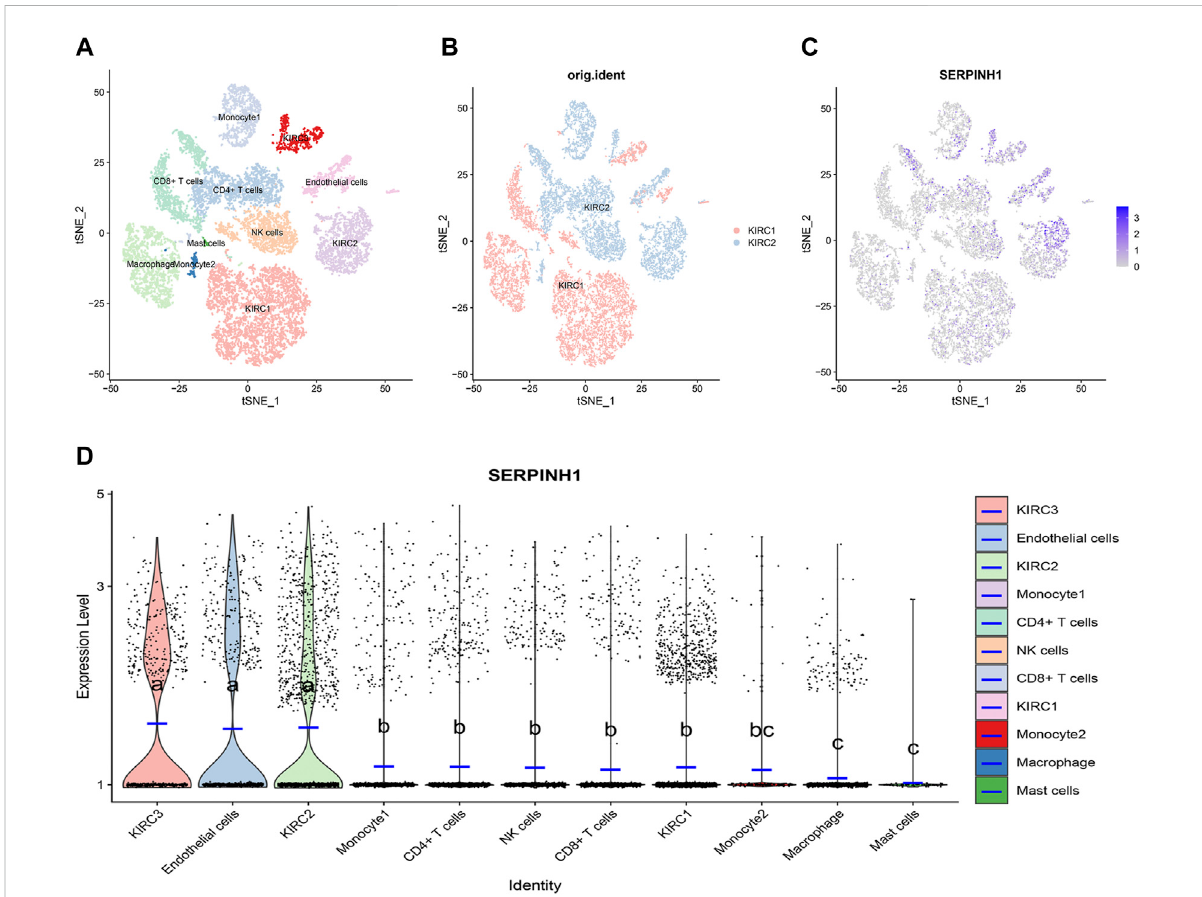
FIGURE 13 Single-cell transcriptomic Atlas of KIRC. (A) tSEN plot representation of KIRC samples with 11 distinct cell types. (B) tSEN plot representation of KIRC from two different samples. (C) tSEN plot representation of SERPINH1 in different cell types. (D) Comparison of SERPINH1 expression in differentKIRCtumormicroenvironmentcells.ThebluehorizontallineontheviolinplotindicatesthemedianSERPINH1expression.Thelettersatthe top indicate a statistical difference between cells for two comparisons. Different letters indicate that the difference is statistically signi fi